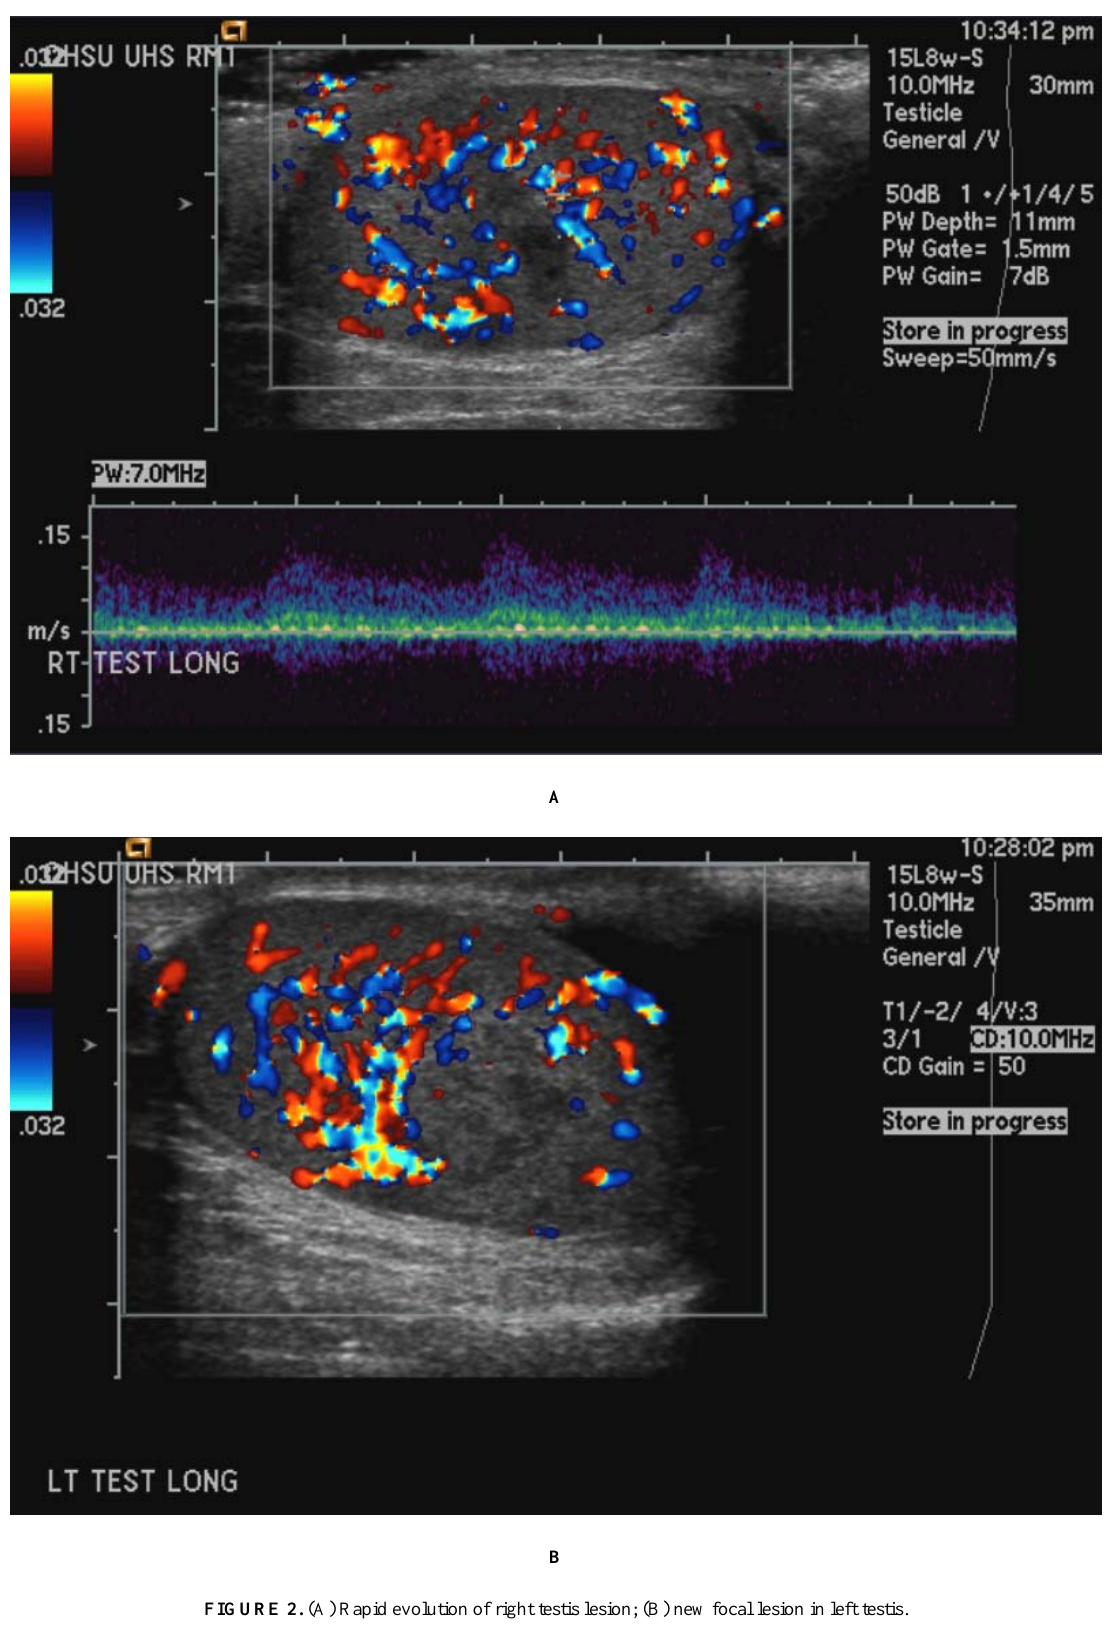
FIGURE 2. (A) Rapid evolution of right testis lesion; (B) new focal lesion in left